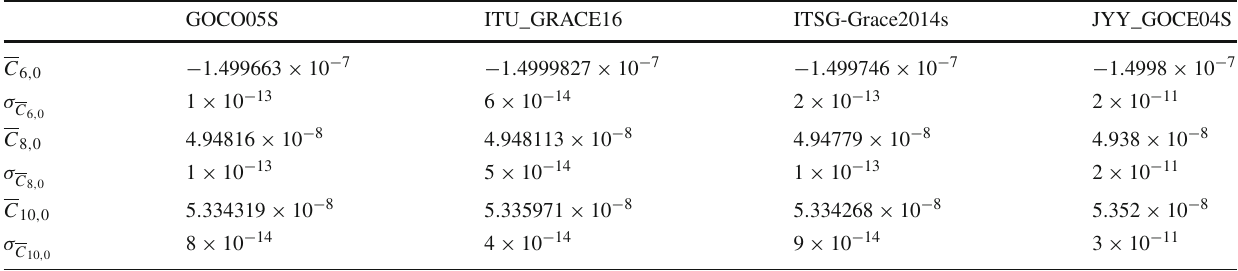
Table 2 Estimated values C (cid:3), 0 and formal errors σ even zonal harmonics of degree (cid:3) = 6 , 8 , 10 according to the Earth’s global gravity field solutions GOCO05S, ITU_GRACE16,